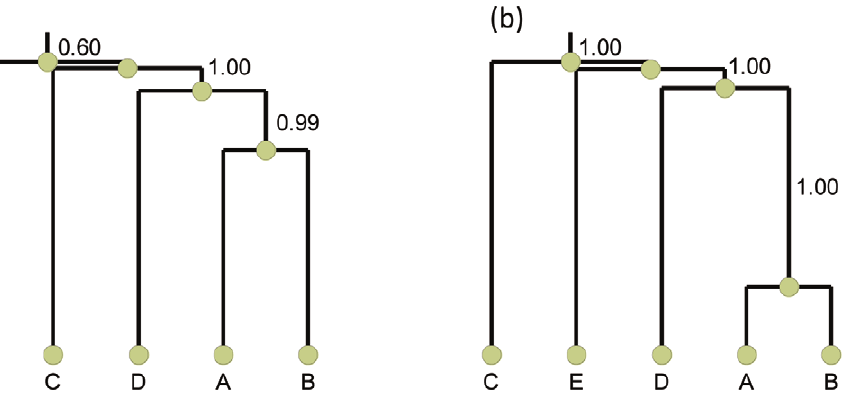
Figure 1. Clustering of the five editing sites using Jaccard distance in (a) human and (b) rat. Each edge is assigned with a confidence level according to the fraction of times by which it was supported by the different